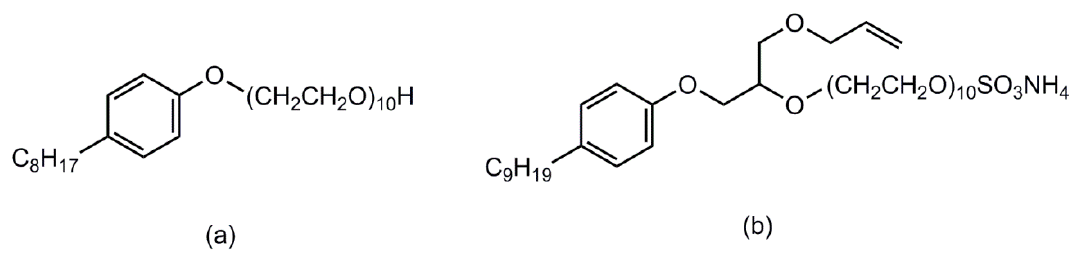
Figure 1. The chemical structures of emulsifiers: ( a ) octylphenol polyoxyethylene ether (10) (OP-10) and ( b ) ammonium sulfate allyloxy nonylphenoxy poly(ethyleneoxy) (10)